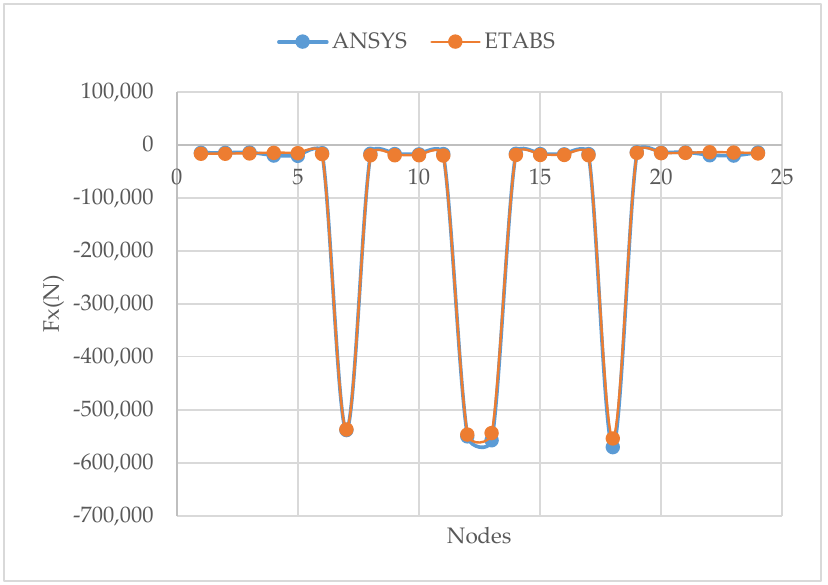
Figure 4. Comparison of the predicted F x reactions for the 8-story building under earthquake loading in ANSYS and ETABS.